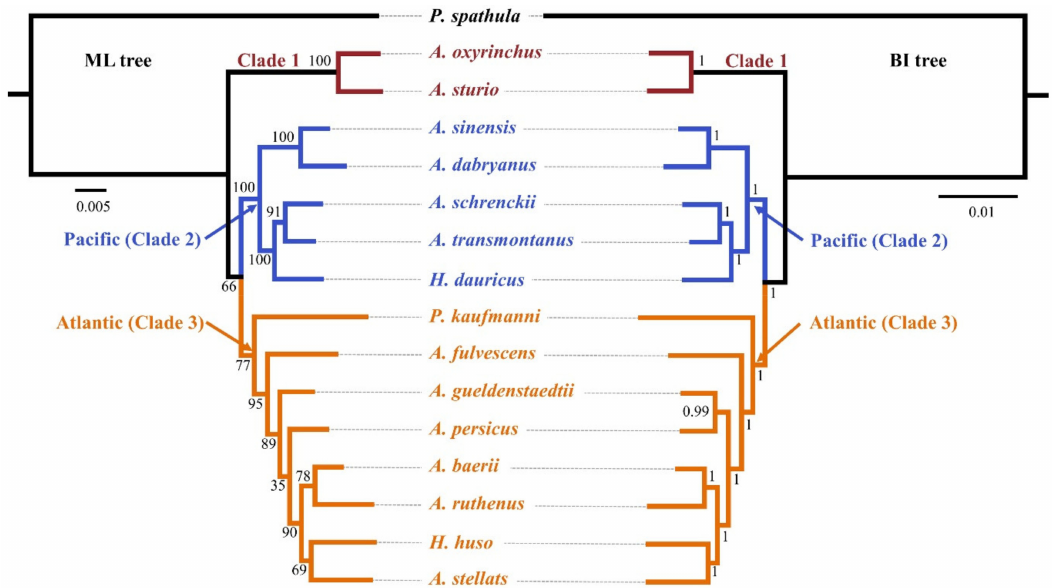
Figure 1. Phylogenetic relationships of Acipenseriformes inferred from 30 nuclear protein-coding (NPC) markers. Left: maximum likelihood (ML) tree; right: Bayesian inference (BI) tree; bootstrap support and Bayesian posterior probability are shown on the nodes.